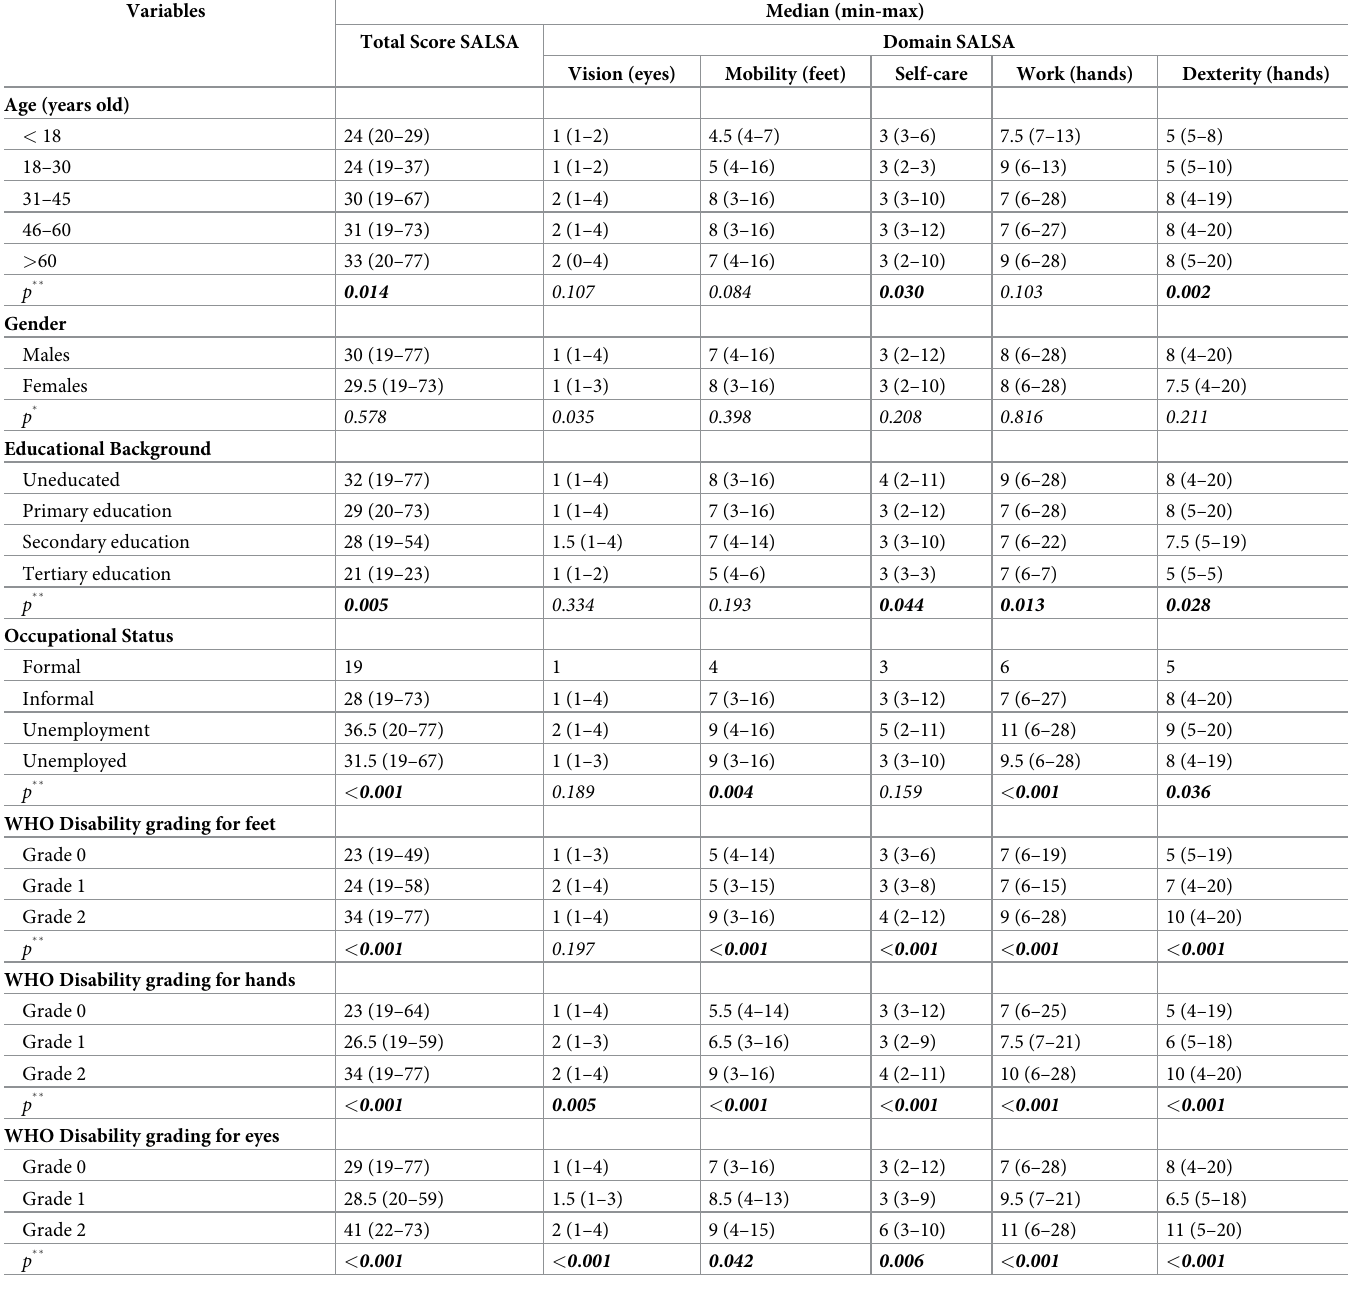
Table 2. Comparison of SALSA Score among demographic and clinical